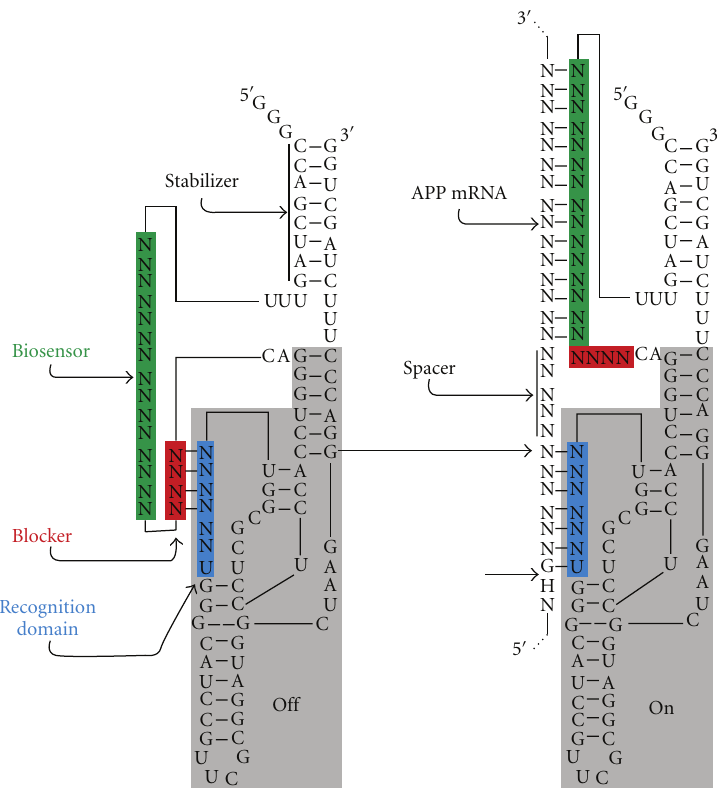
Figure 1: Secondary structure of both the O ff and On conformations of the SOFA-HDV ribozyme. The original HDV ribozymes in the grey shaded boxes with its recognition domain (in blue) indicated. The SOFA is composed of three motifs: the biosensor (in green), blocker (in red), and stabilizer stem. Upon the addition of APP mRNA, sequence-specific hybridization to the ribozyme occurs, and the substrate is subsequently